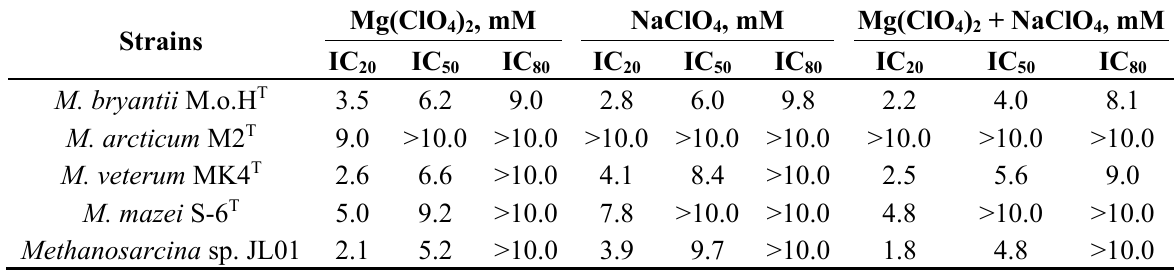
Table 2. Inhibitory effect of Mg(ClO 4 ) 2 and NaClO 4 on the growth of permafrost and nonpermafrost